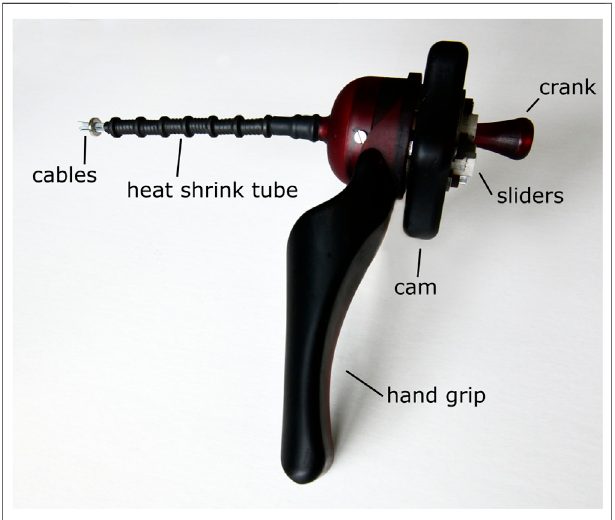
FIGURE 8 | Photo of the fl exible ovipositor-inspired tissue transport mechanism with an extra ring magnet around the tip of the shaft to elucidate the working principle.